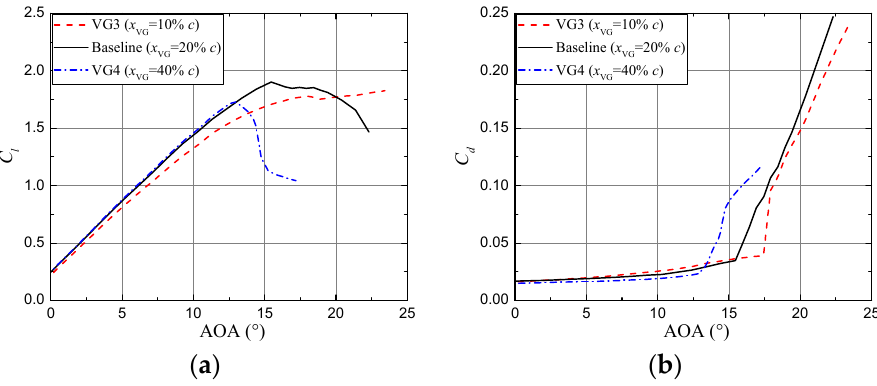
Figure 17. Experimental lift and drag coefficients of the stationary airfoil with different VGs in chordwise installation. ( a ) C l ; ( b ) C d .